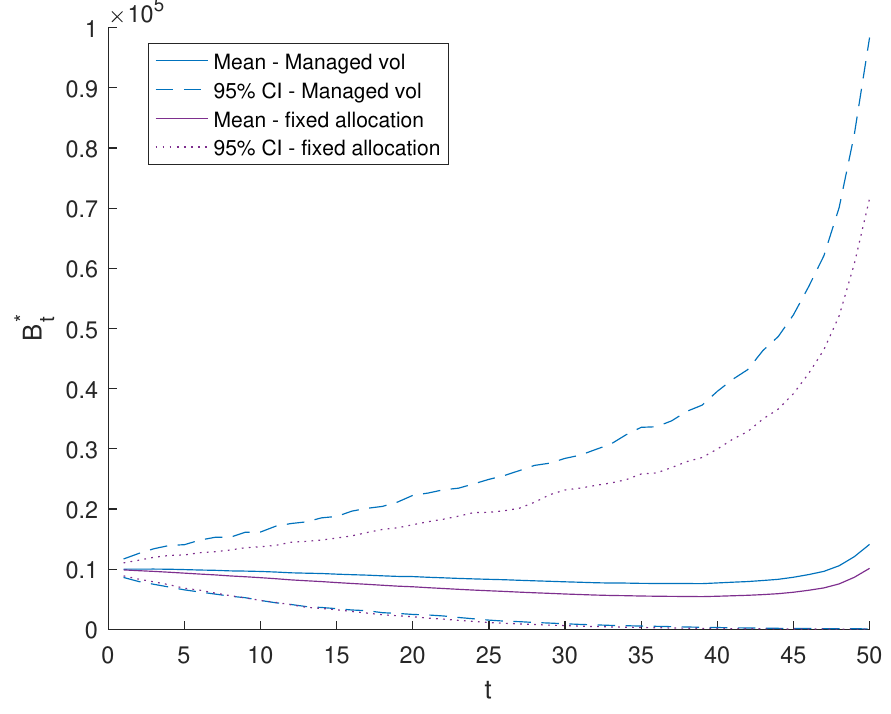
Figure 2. The 95% confidence interval of annuity payments. Managed-Volatility vs. Fixed Allocation